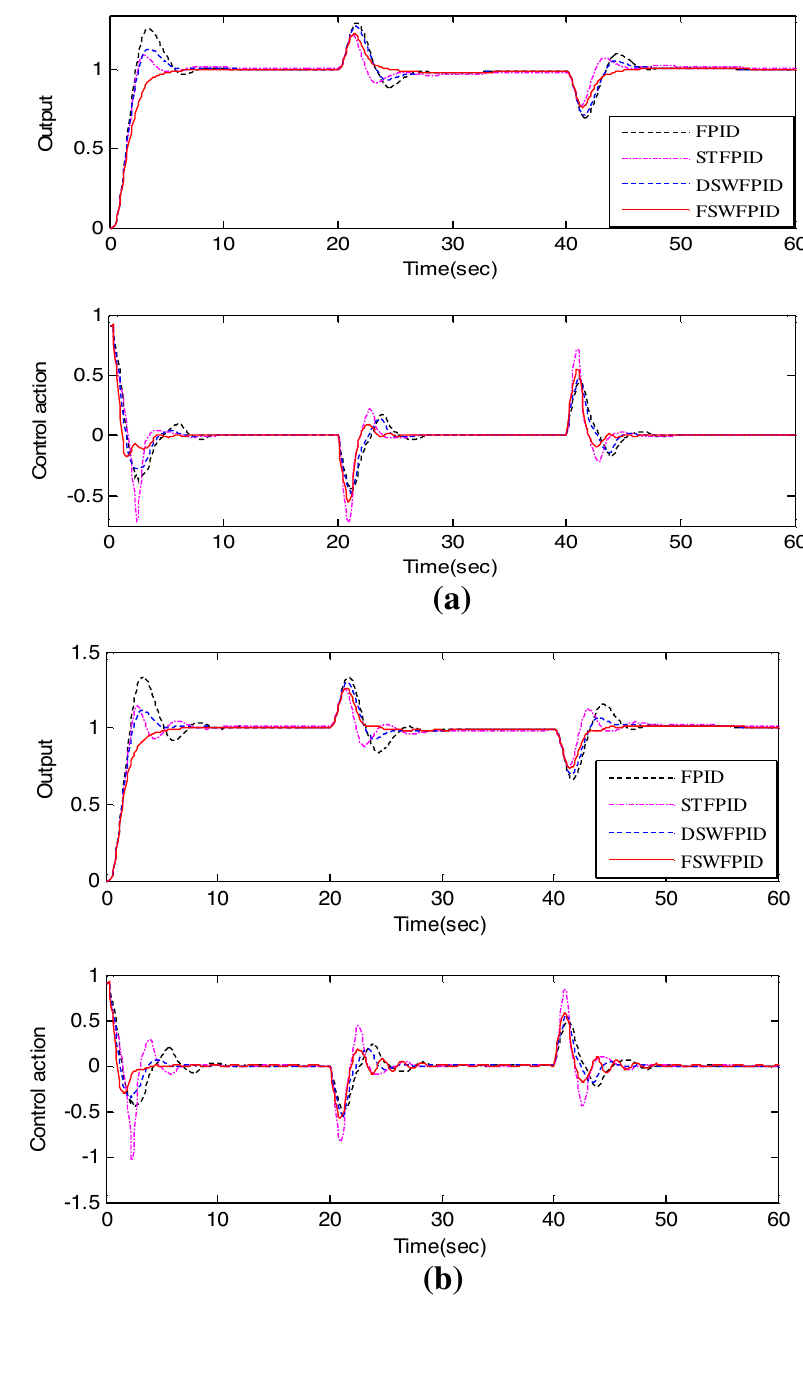
Fig. 16 Responses and control actions for Model IV using 49 rules during set point response and with load variation for a L = 0.2 s, b L = 0.3